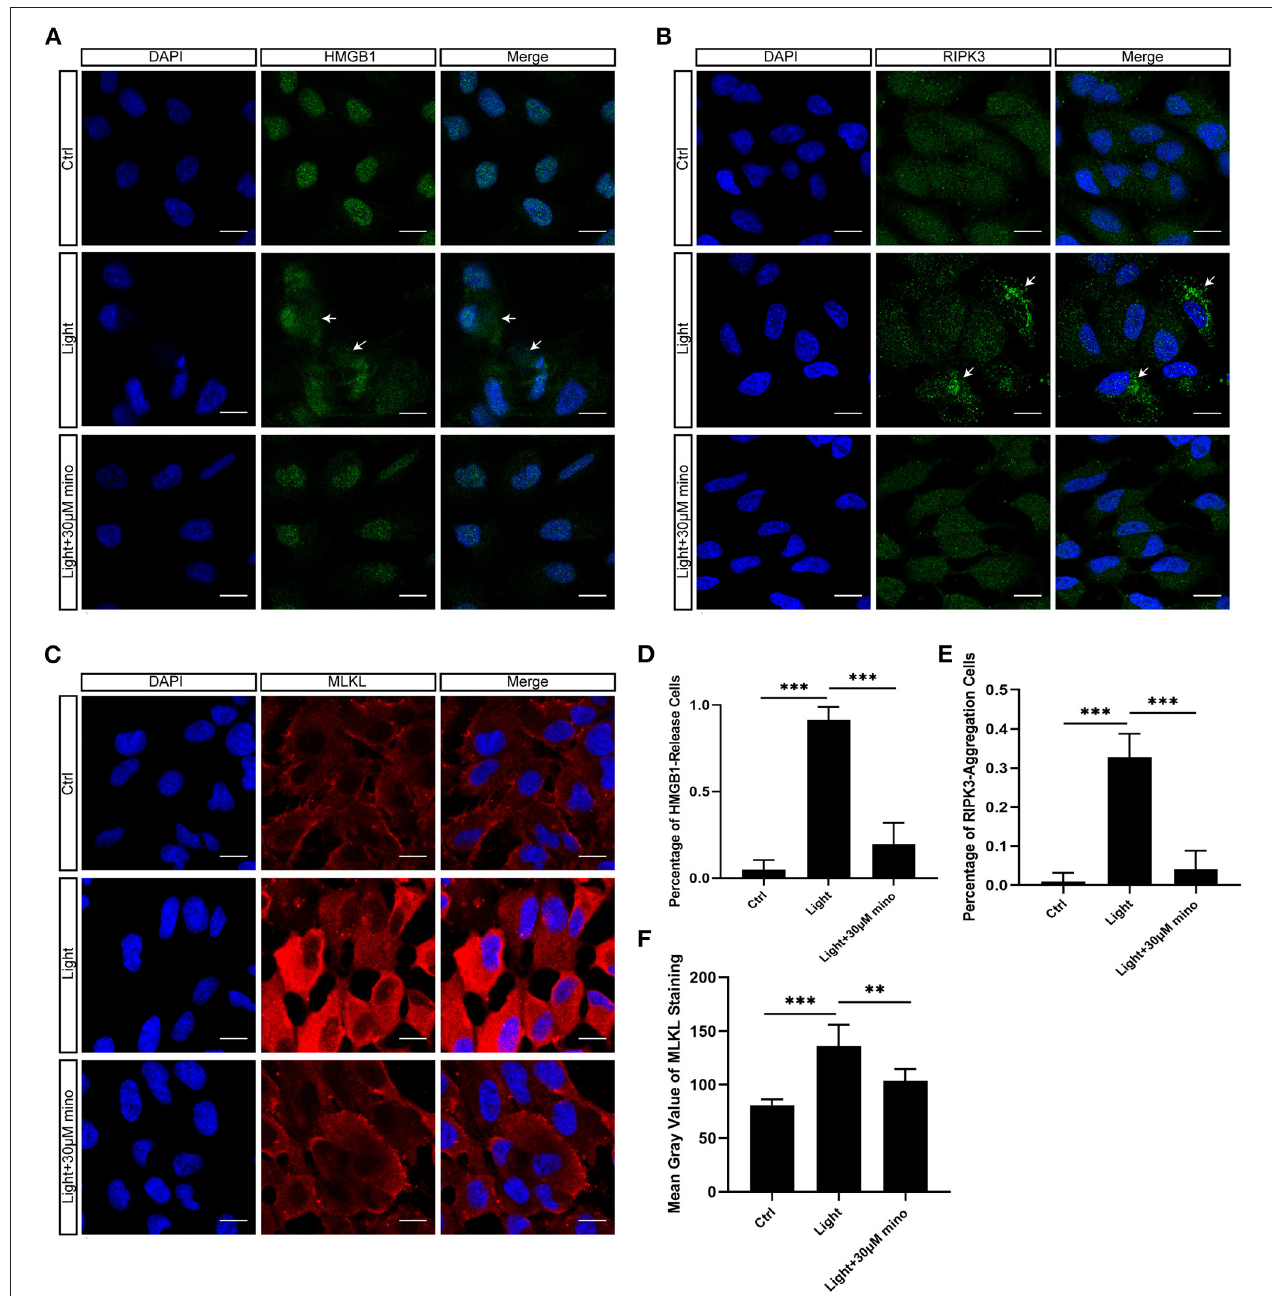
FIGURE 4 | Immunofluorescence verification of necroptosis molecular hallmarks in blue-light-induced RPE in vitro . ARPE-19 cells were exposed to blue light for 2h and further cultured for 2h before immunofluorescence experiments. (A) Blue light caused release of HMGB1 from nuclei of ARPE-19 cells. White arrows indicated release of HMGB1 from nuclei. Minocycline treatment significantly reduced release of HMGB1 from nucleus. Scale bar: 15 µ m. (B) Blue light caused aggregation of RIPK3 and enhancement of local fluorescence intensity in ARPE-19 cells. White arrows indicated aggregation of RIPK3. RIPK3 aggregation was evidently alleviated in light with minocycline group cells. Scale bar: 15 µ m. (C) Compared with blue light-induced cells, MLKL staining was light in normal APRE-19 cells and slightly obvious at cell edge. After blue light exposure, fluorescence of MLKL staining was obvious and homogeneous. In blue light with minocycline group cells, fluorescence characteristics were between control group and blue light exposure group. Scale bar: 15 µ m. (D) Quantitative fluorescence analysis of (A) ( n = 6). (E) Quantitative fluorescence analysis of (B) ( n = 6). (F) Quantitative fluorescence analysis of (C) ( n = 6). ** p < 0.01, *** p < 0.001.